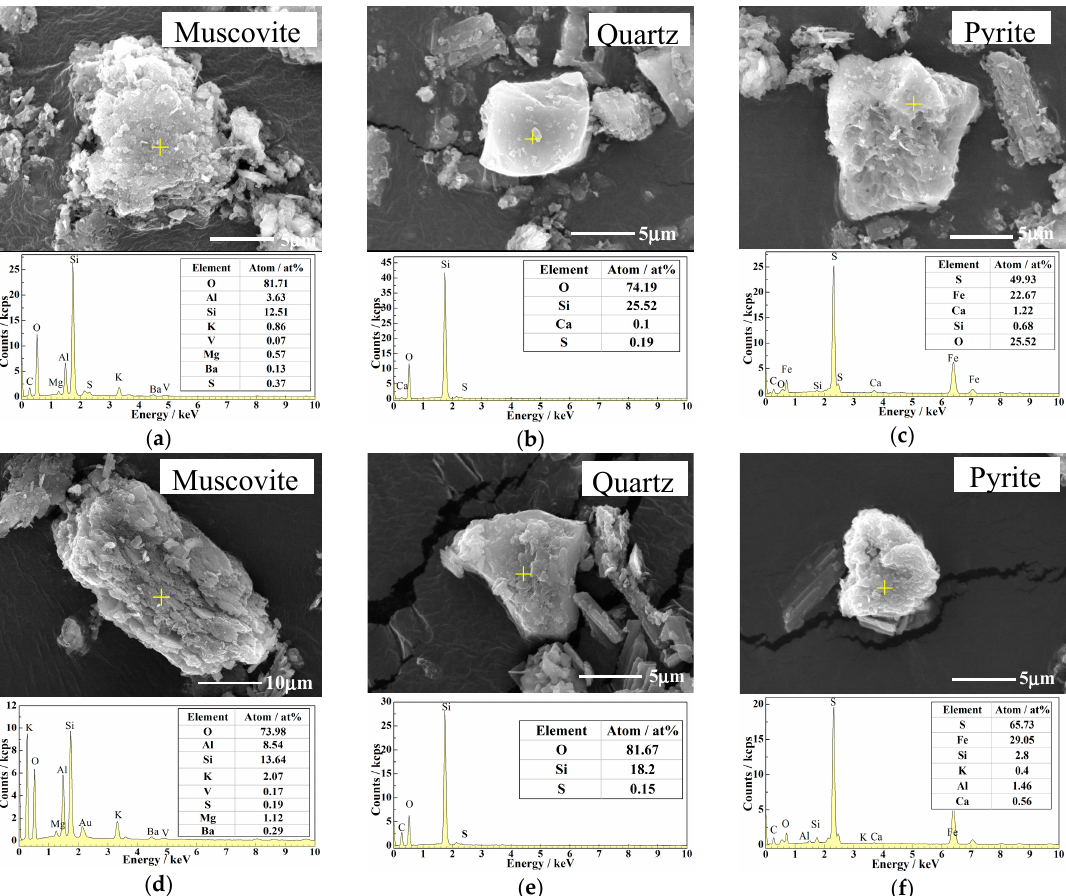
Figure 5. The SEM-EDS results of the residues in Run 17: ( a – c ) in MH and ( d – f ) in CH.